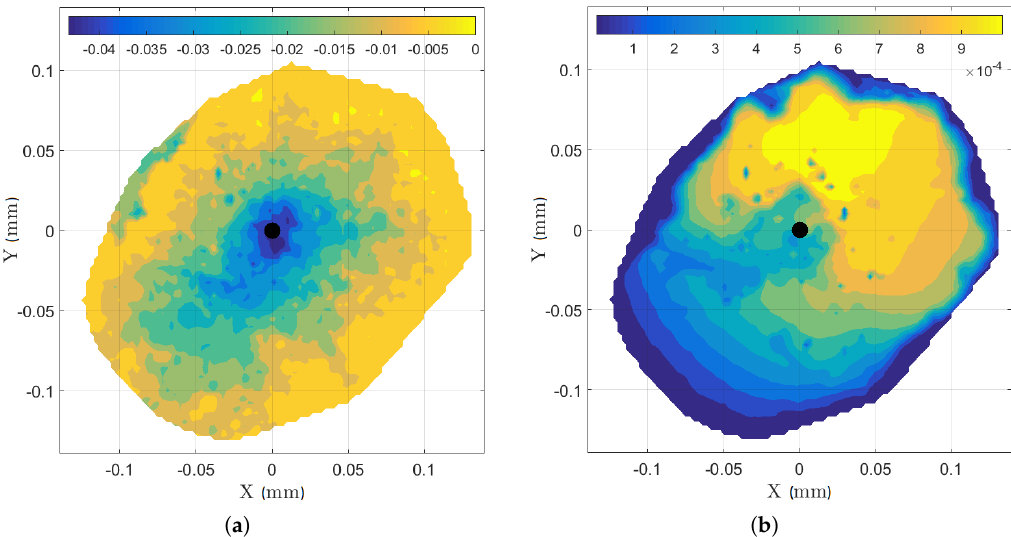
Figure 15. ( a ) Top view of the top concrete cone depth; and ( b ) top view of the top cone crack width (both in